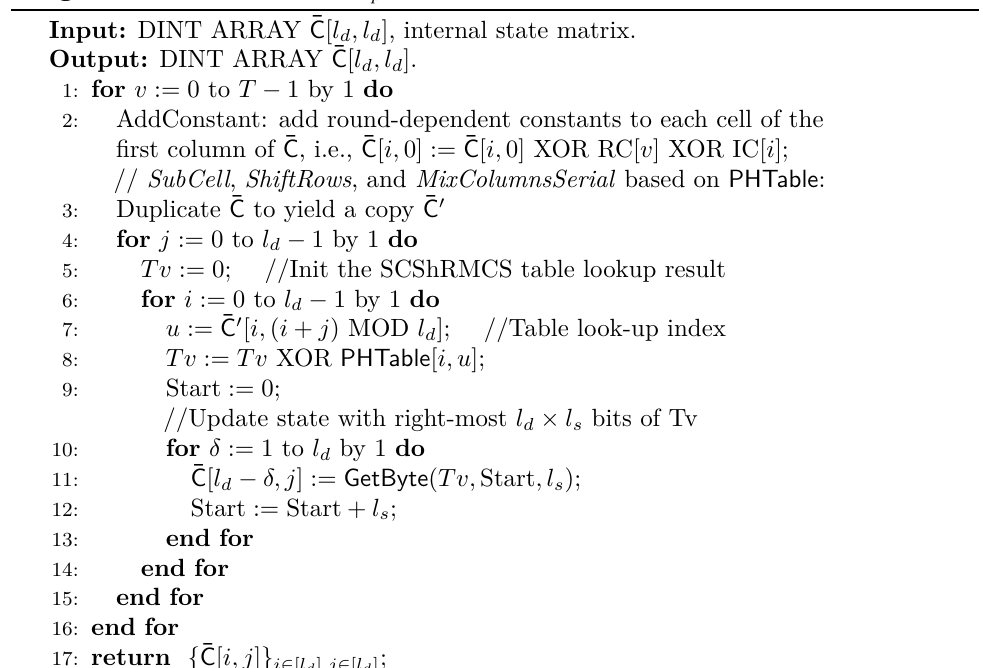
Algorithm 10: Permutation π p of